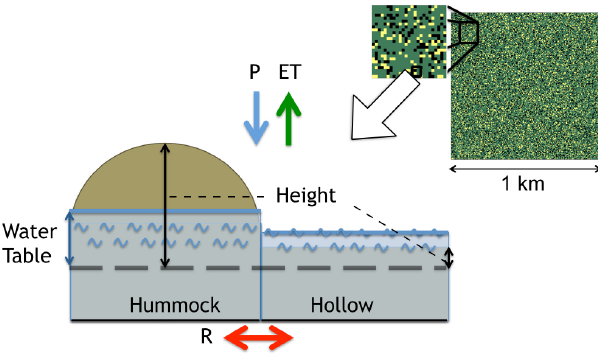
Figure 1. Schematics of the HH model. The model represents a 1 × 1km peatland, and works at a 1m resolution. It is therefore able to resolve the micro-topographical features such as hummocks and hollows. Each grid cell has an elevation which is randomly assigned from the distribution of elevation data collected in the Ust-Pojeg mire complex in the Komi Republic, Russia. For each grid cell we simulate a dynamical water table, which changes with precipitation (P in the figure), evapotranspiration (ET), and lateral runoff (R). In the Single Bucket model version all quantities are averaged, in order to assess the effect of the representation of micro-topography if compared to a mean field